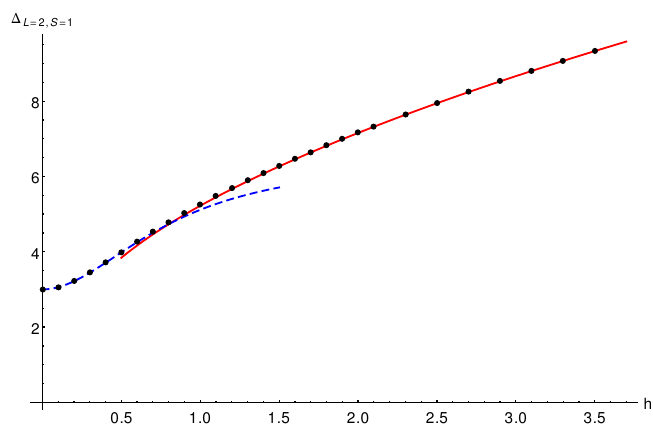
Figure 9 . Plot of (cid:1) L =2 ;S =1 as a function of h : the dots correspond to the numerical data reported in table 8 of appendix D.2, while the solid line and the dashed line represent the strong coupling expansion (5.8) and the weak coupling Pad(cid:19)e approximant (5.11)